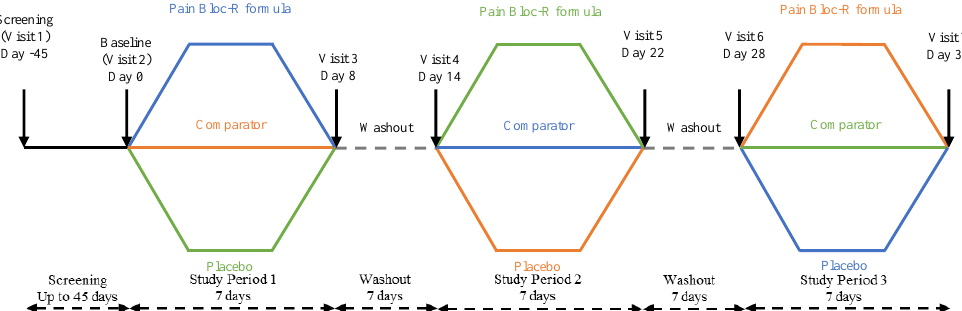
Figure 1. Study design. The study design was a randomized, double blind, placebo-controlled, crossover study. Healthy participants ( n = 27) were randomized equally to each of the study arms. The trial consisted of three intervention periods and two wash-out periods, lasting a total of five continuous weeks.